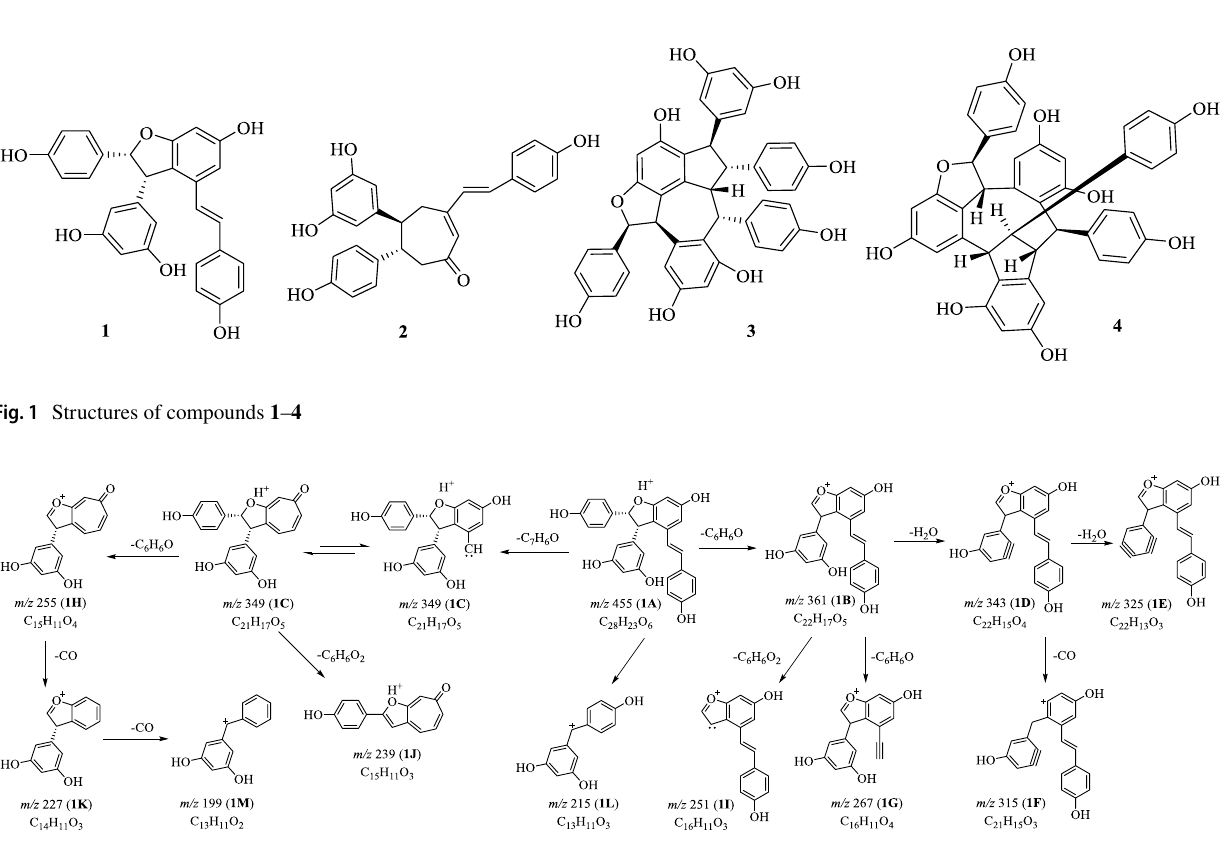
Fig. 2 Proposed fragmentation pathways of (−)-7,8- cis - ε -viniferin ( 1 ) in positive